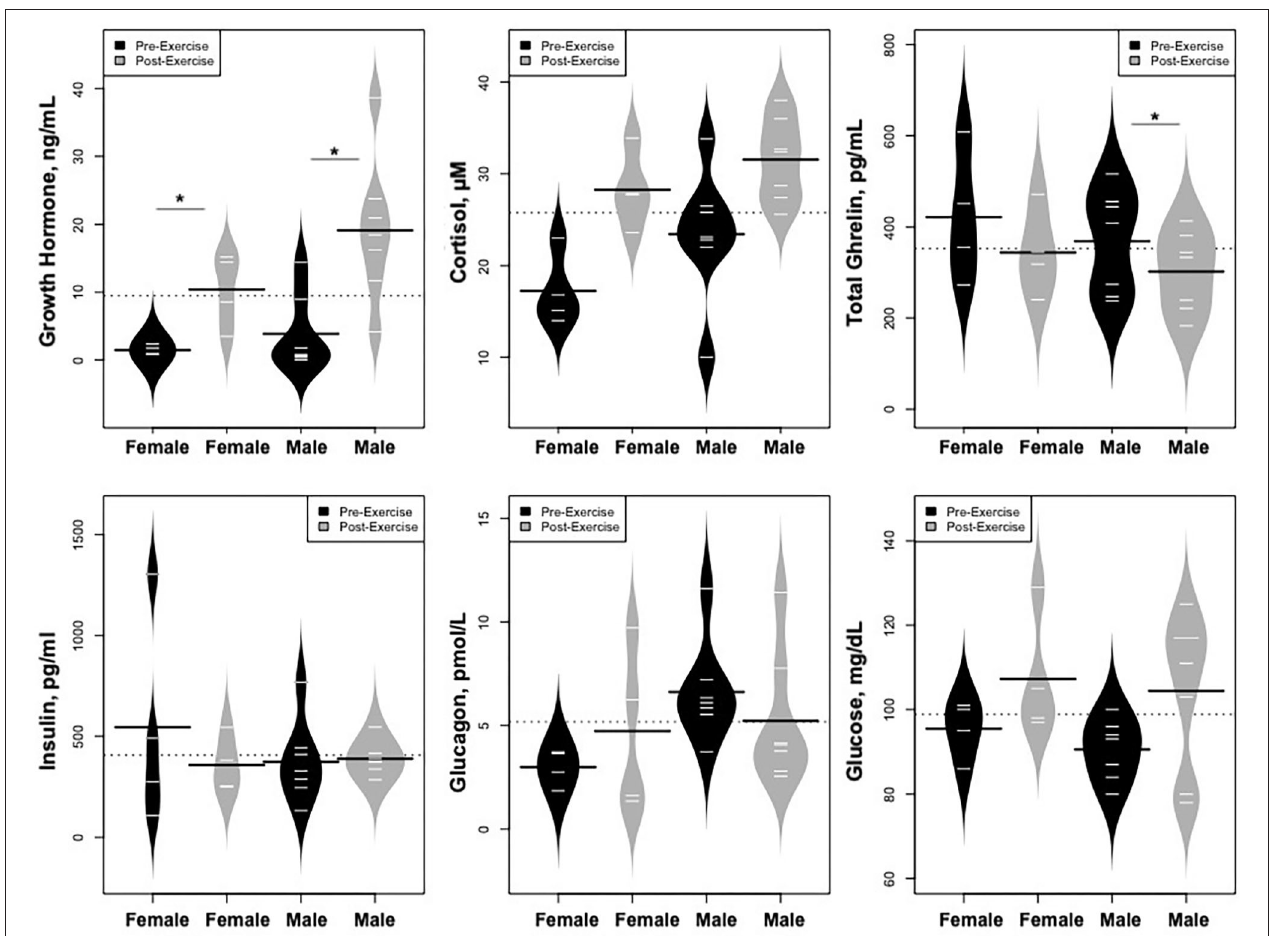
FIGURE 9 | Changes in hormones controlling changes in metabolites and changes in glucose concentrations, * p <